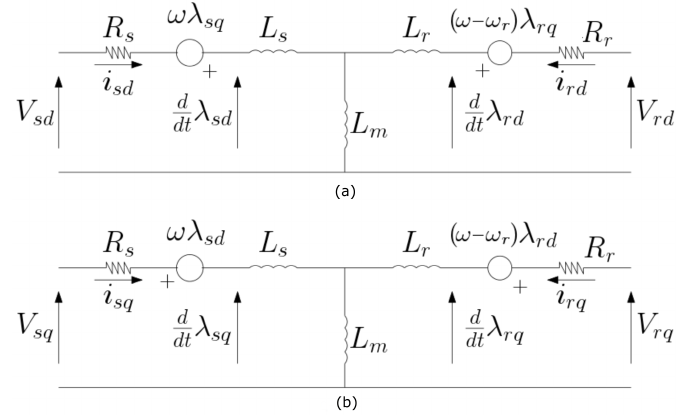
Figure 2. Induction generator dq equivalent circuit, based on [27], where ( a ) represents the d-axis and ( b ) represents the q-axis